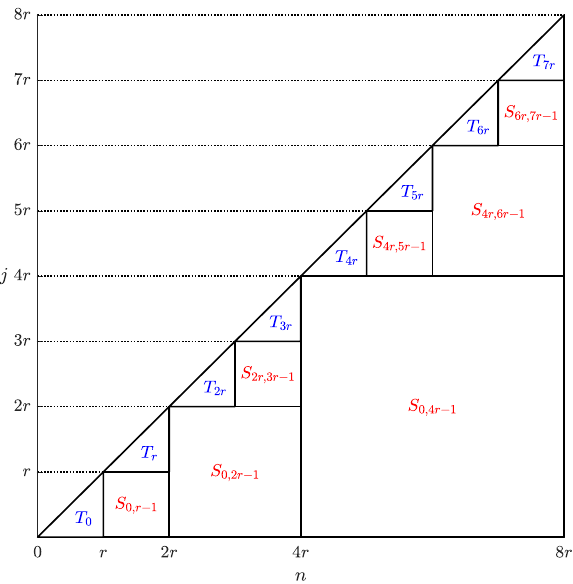
Figure 2. Splitting of the computation of T 0 ( n ) into partial sums S p , q (red-labeled squares) and final blocks T p (blue-labeled